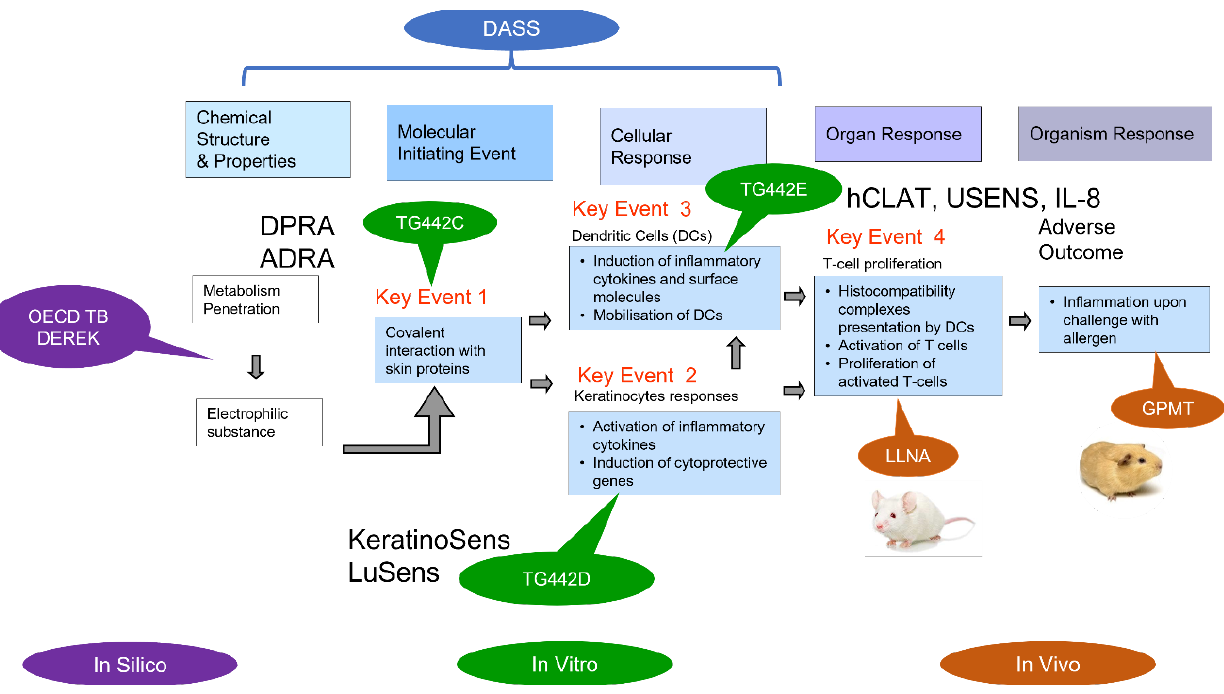
Figure 2. Overview of defined approach (DA) for skin sensitization. The DA for skin sensitization starts with in silico and in vitro approaches mapped to the adverse outcome pathway (AOP). (Part of NAM-01 presentation, Supplemental